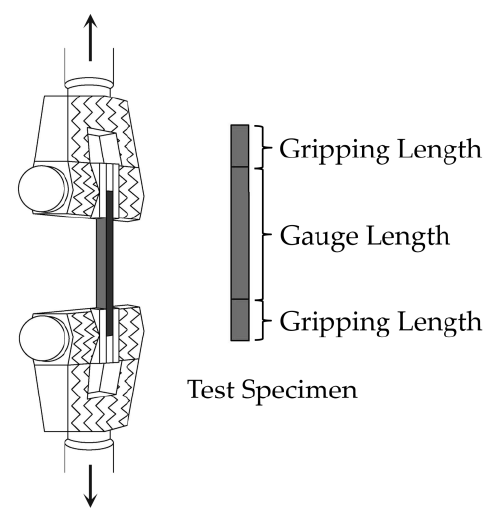
Figure 2. Illustration of the defined gauge length of a rattan strip evaluated in this experiment.